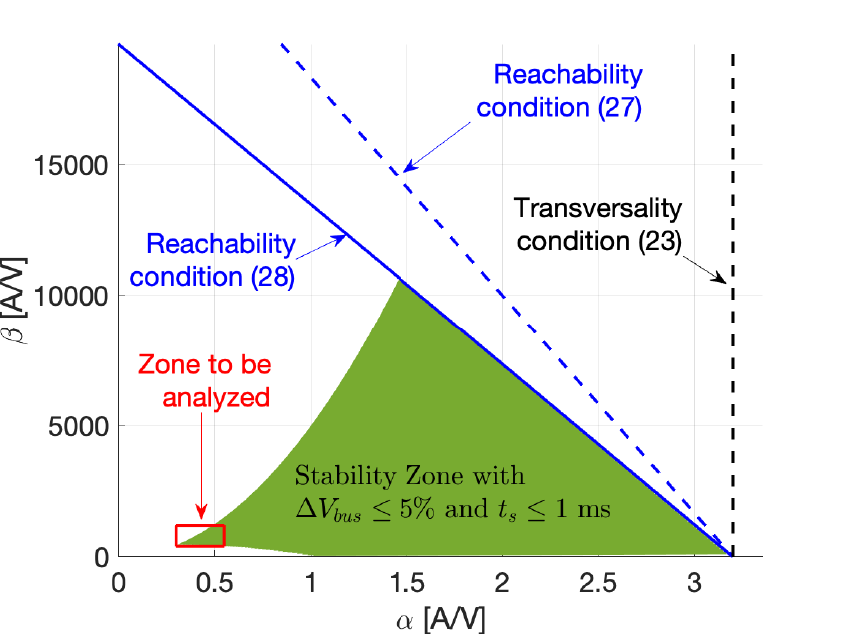
Figure 5. Analysis of the zone imposed by the stability restrictions for ∆ V bus ≤ 5% and t s ≤ 1